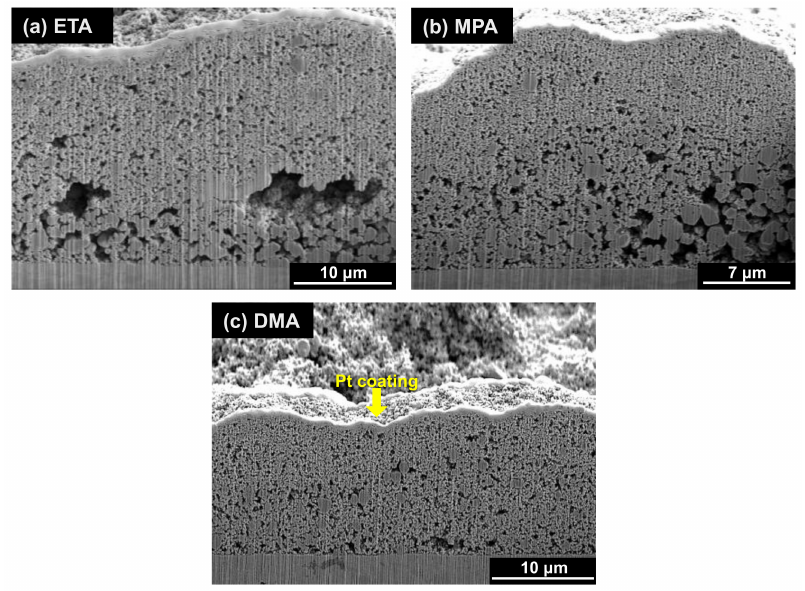
Figure 9. Cross-sectional SEM images of magnetite deposits on Alloy 690TT tubes depending on which of the three advanced amines was used: ( a ) ETA, ( b ) MPA, and ( c )